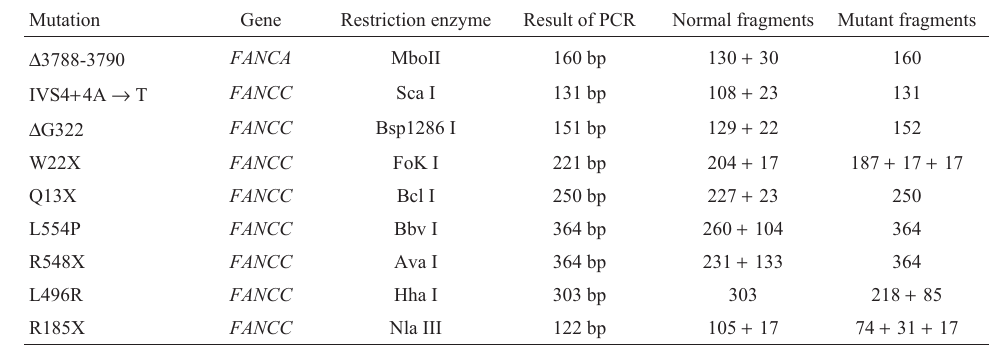
Table 1 - Fragments observed after digestion with respective restriction enzymes for the distinct analysed mutations in Fanconi anaemia patients. Mutation